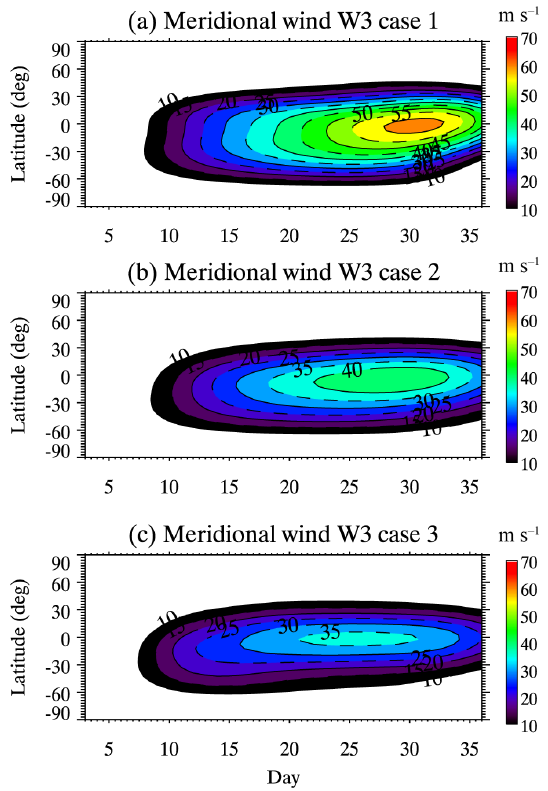
Figure 6. The temporal variations of the W3 at 90km for (a) case 1, (b) case 2, and (c) case 3. Geopotential height perturbations of 1000m are forced at the lower boundary for all the three control runs to simulate the W3. SPW1 geopotential height perturbations of 1000 and 2800m are forced at the lower boundary to induce the weak and strong SSWs in case 2 and case 3, respectively. No SPW1 perturbations are forced at the lower boundary of case 1. The con- tour intervals are 5ms − 1